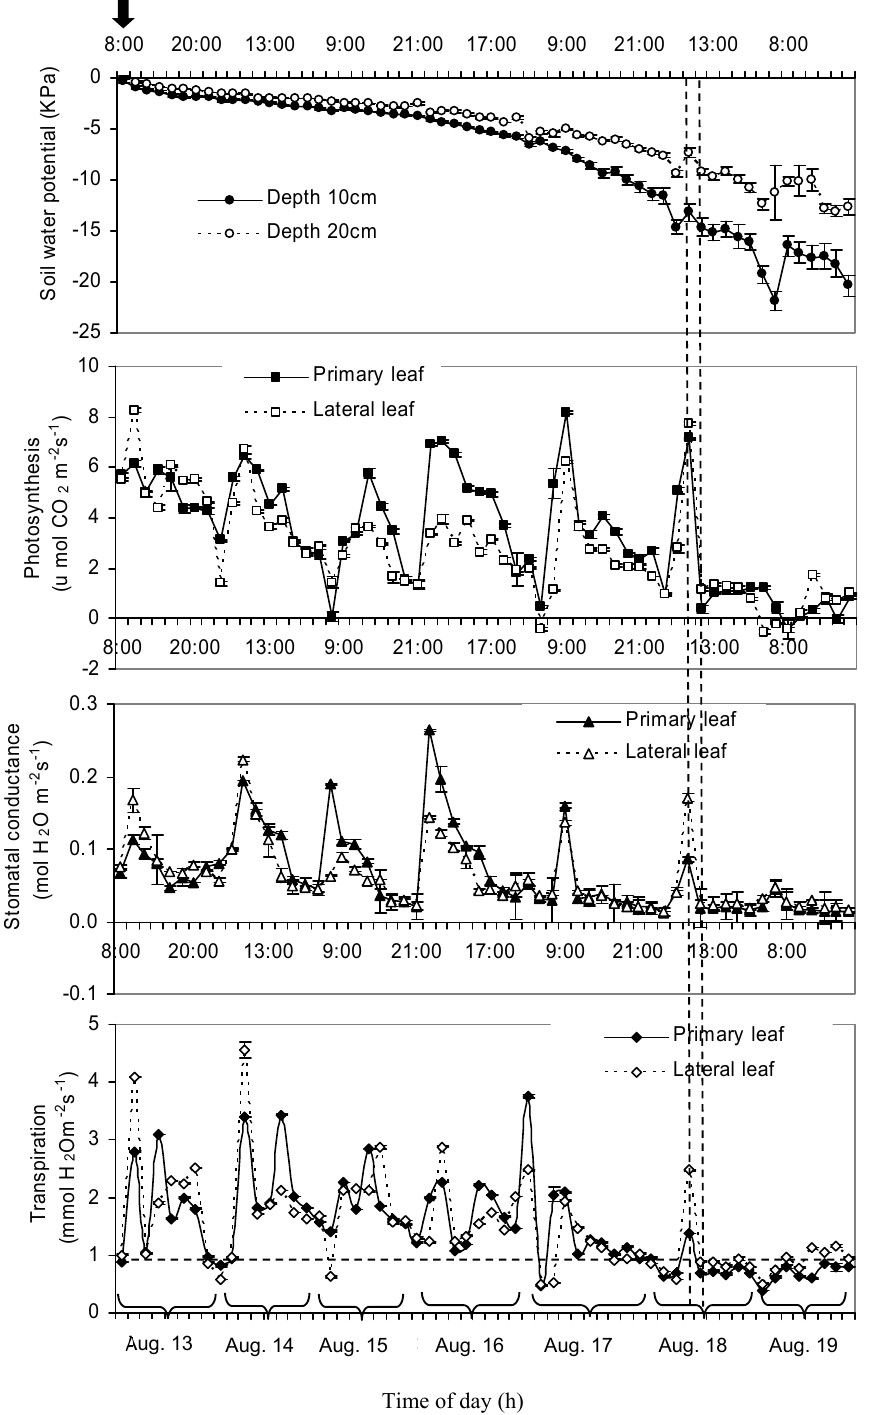
Figure 4. Daily variation of average soil water potential ( ψ ), photosynthesis, stomatal conductance (g s ), and transpiration (E) of grapevine in berry development Stage III. Each symbol represents the average, and error bars represent SE. There were six replicates of measurements for soil water potential, while three replications were measured for photosynthesis, stomatal conductance, and transpiration. The bold arrow represents the irrigation event.